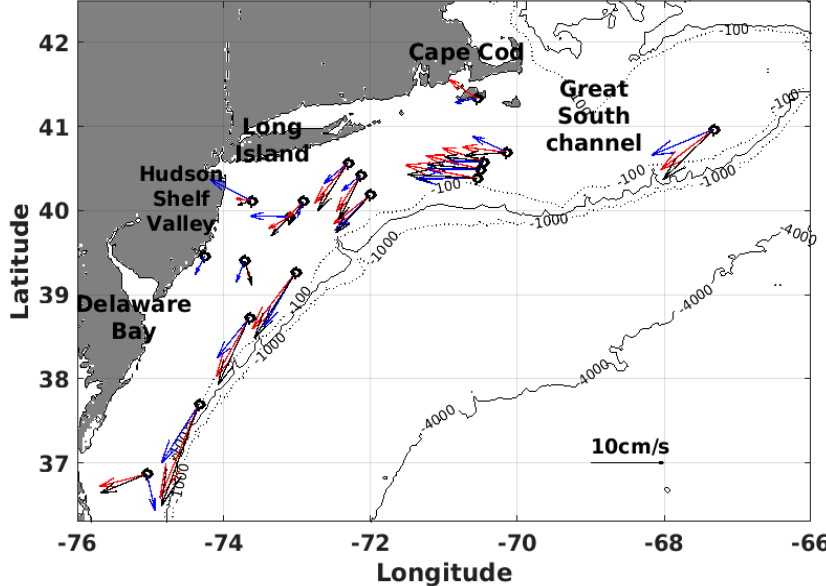
Figure 6. Mean upper ocean current vectors for both in situ current measurements and GlobCurrent products in the MAB on the Northwest Atlantic shelf. In situ data are depth-averaged current vectors U DA from Lentz [26] in blue while GlobCurrent vector currents U G (Geostrophic) and U GE15m (Geostrophic and 15 m Ekman) are in red and black, respectively.